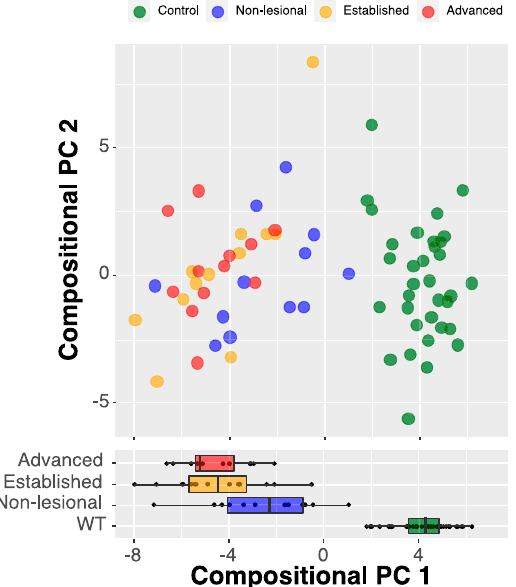
Figure 3. Lipid ions delineate disease stage groups. CPC analysis of all lipid ions plotted vs. disease progression. The model was able to delineate the controls and the three experimental groups of cpdm mice ( η 2 = 0.86, p -value < 0.001).